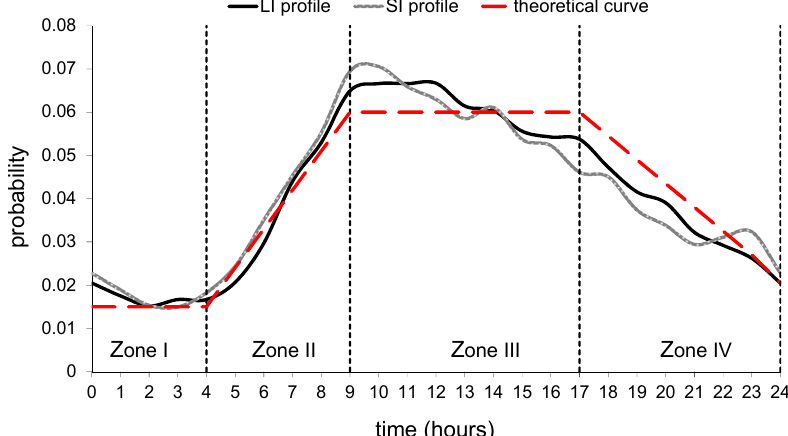
Figure 4. Daily probability of long and short interruptions and their approximation with a theoretical curve.